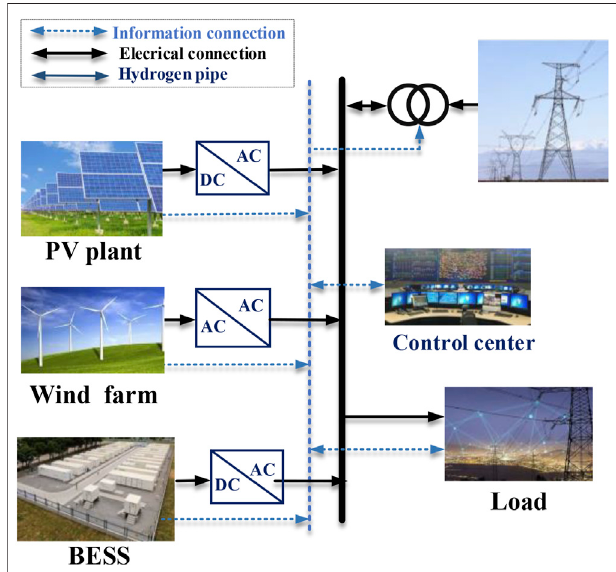
FIGURE 1 | Typical con fi guration of the BESS directly connected to the power